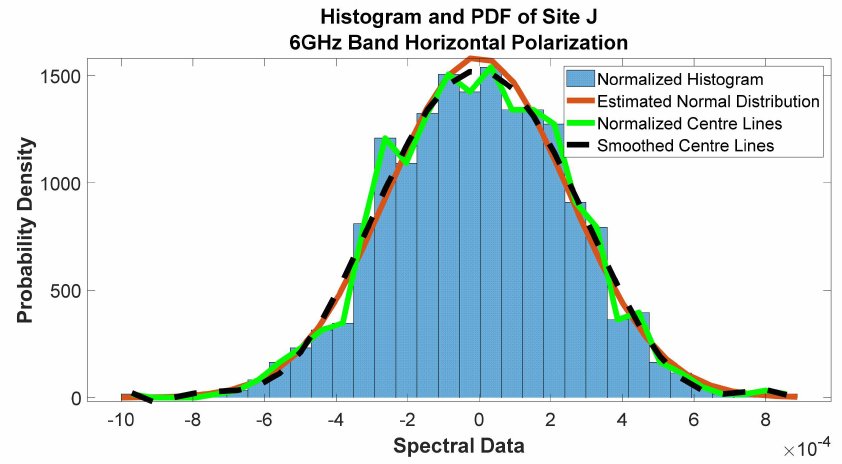
Figure 53. Histogram and PDF of site J at 6 GHz band horizontal